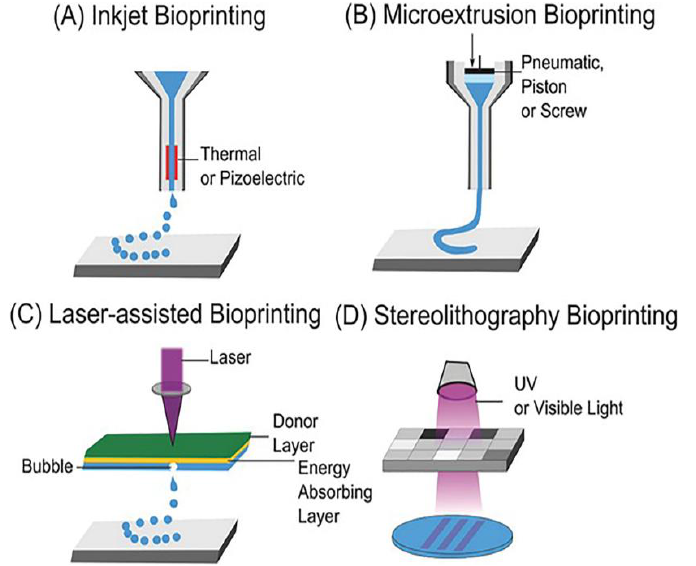
Figure 2. Representation of the main 3D Bioprinting technologies. ( A ) Inkjet Bioprinting, ( B ) Micro extrusion Bioprinting, ( C ) Laser-assisted Bioprinting, and ( D ) Stereolithography Bioprinting. Reproduced from [2], Copyright 2018, Wiley.